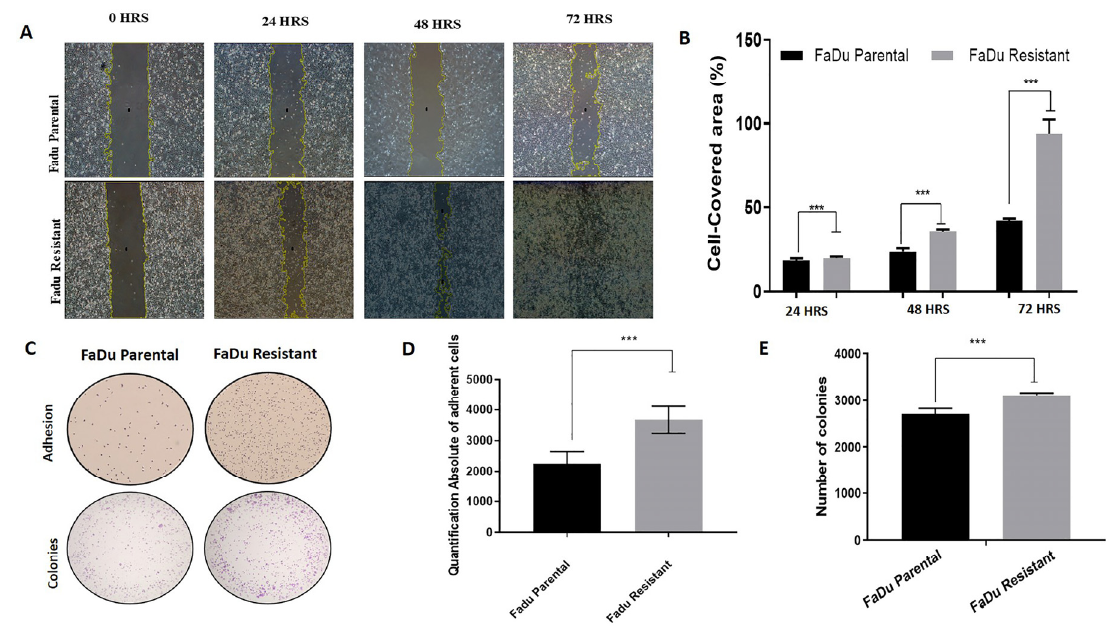
Figure 6. Malignant phenotype acquired after cetuximab resistance establishment. ( A ) Representative images of wound healing assay of FaDu parental and FaDu resistant cell lines in 24, 48, and 72 h. The yellow lines represent the distance between both edges of the wound; Scale bars, 200 µ m; ( B ) Migra- tion rates of FaDu parental and FaDu resistant cells in a wound-healing assay; ( C ) Representative images of adhesion and clonogenic assay for parental and resistant cells; ( D ) The absolute number of adherent cells; ( E ) The absolute number of colonies in clonogenic cell assay for anchorage-dependent in parental and resistant cells. (*** p < 0.0001). The images were acquired in 10 × magnification.